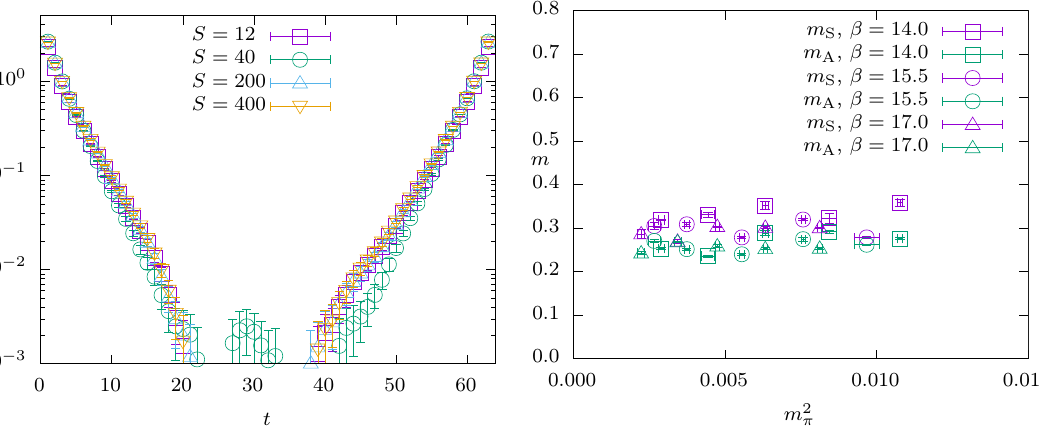
Figure 12. Left: gluino-glue correlation function C ( t ) as function of the temporal extend t at (cid:12) = 17 and m f = (cid:0) 0 : 1350 for di(cid:11)erent smearing levels S . Right: gluino-glue mass as a function of the squared pion